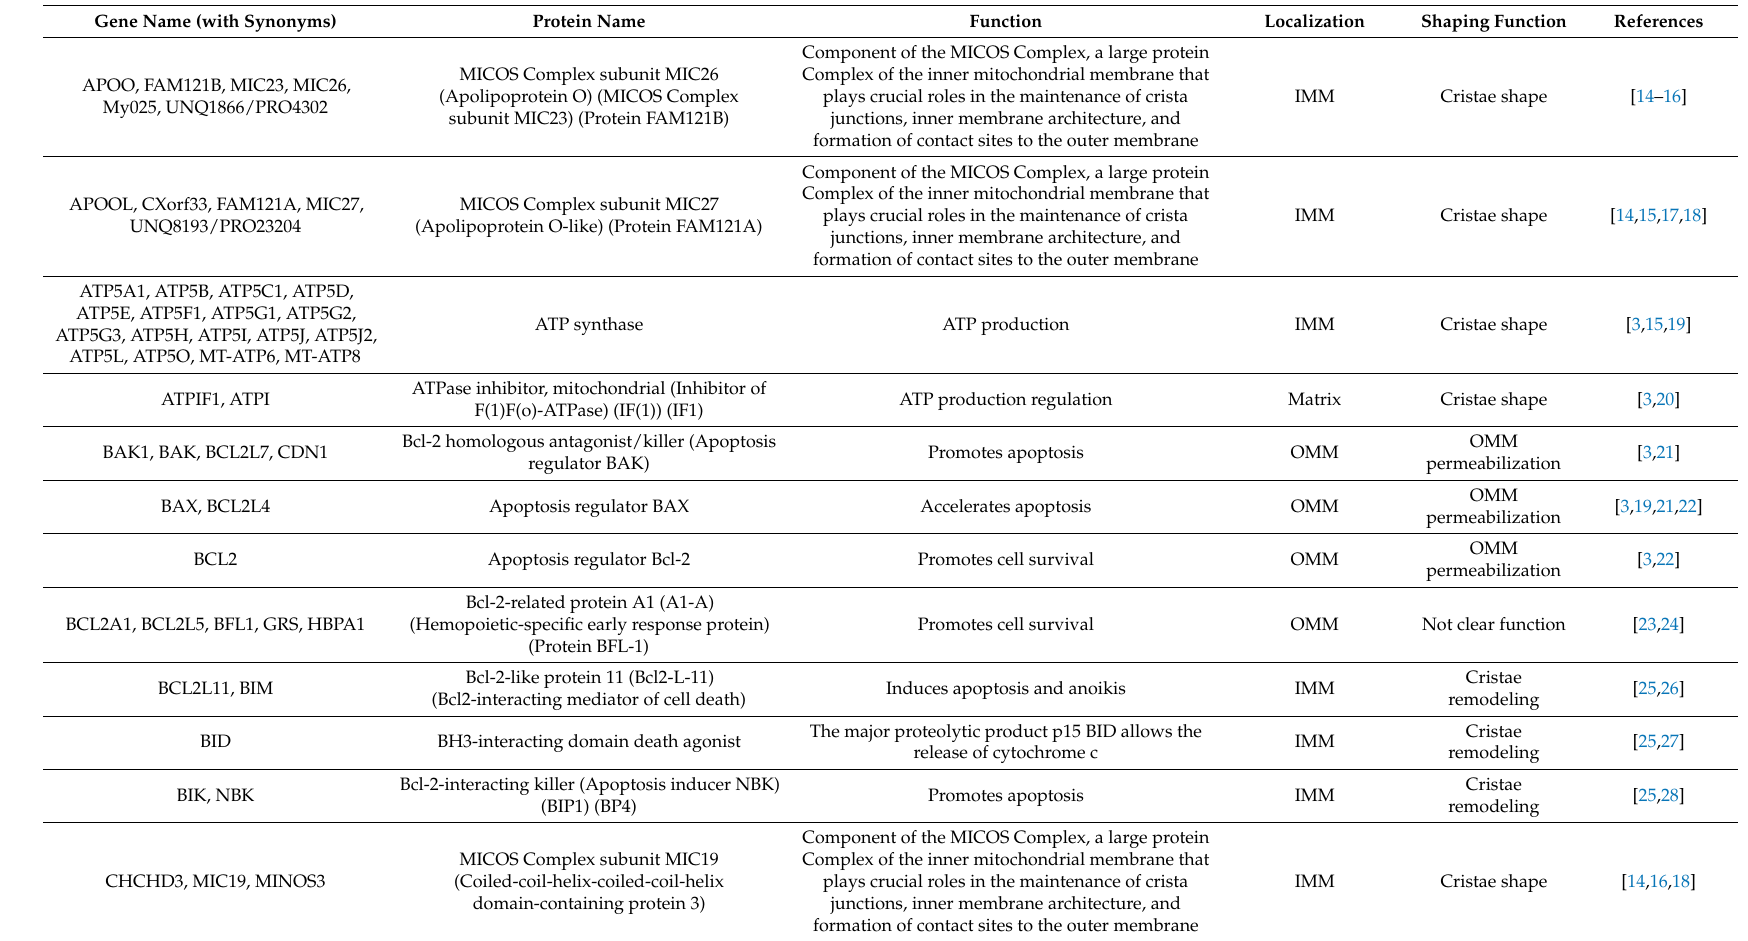
Table 1. List of mitochondrial-shaping